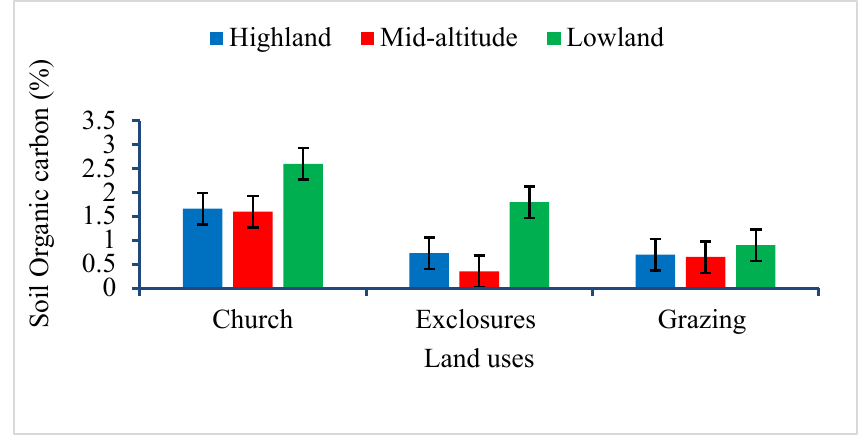
Figure 6. Soil organic carbon in different soil depth and land uses.